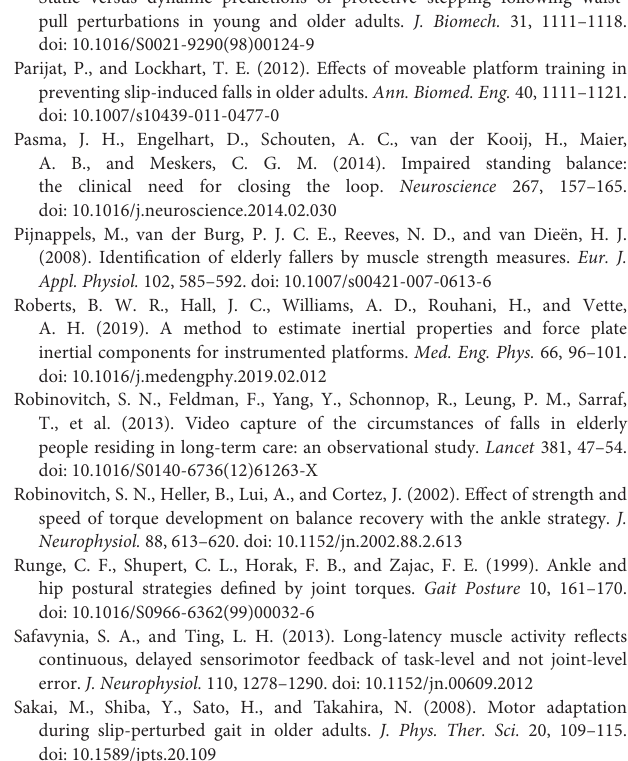
following fatiguing foot muscle exercises. PLoS One